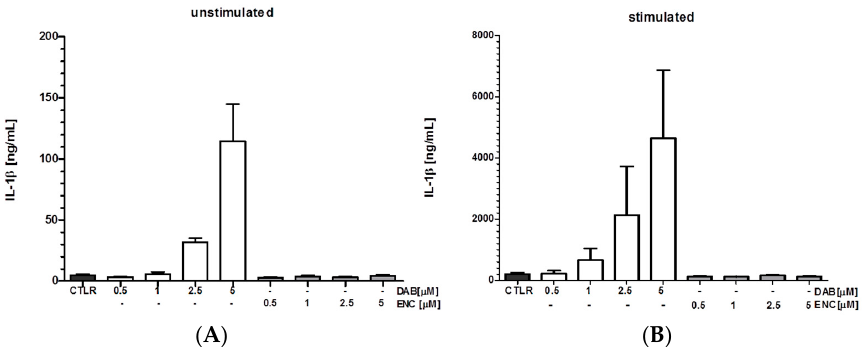
Figure 4. Effects of BRAF inhibitors on IL-1 β production by DC. Murine bone marrow-derived DC at ( A ) unstimulated state or ( B ) treated with LPS [100 ng/mL] were (co)administered with varying doses of BRAF inhibitors. DAB, but not ENC induced IL-1 β production in DC at either state of activation (mean ± SD; n = 4).